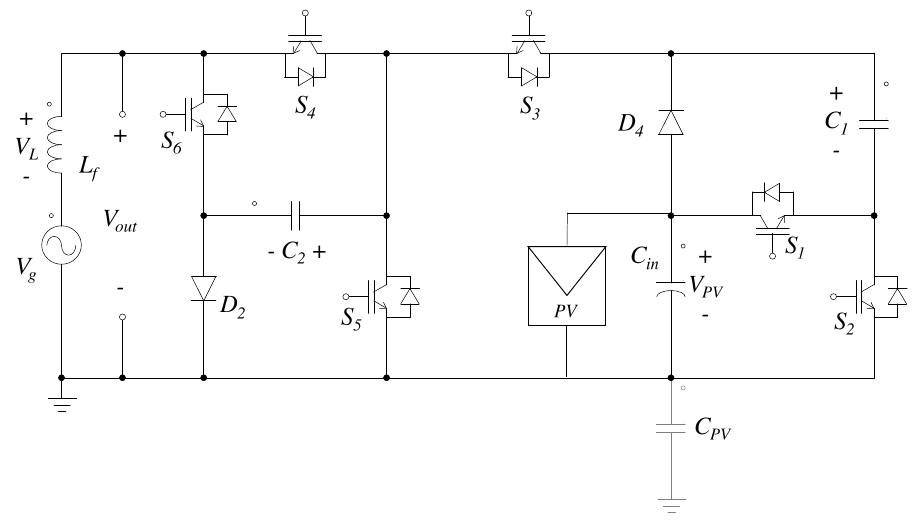
Figure 7. Grid-connected inverter topology proposed in Reference